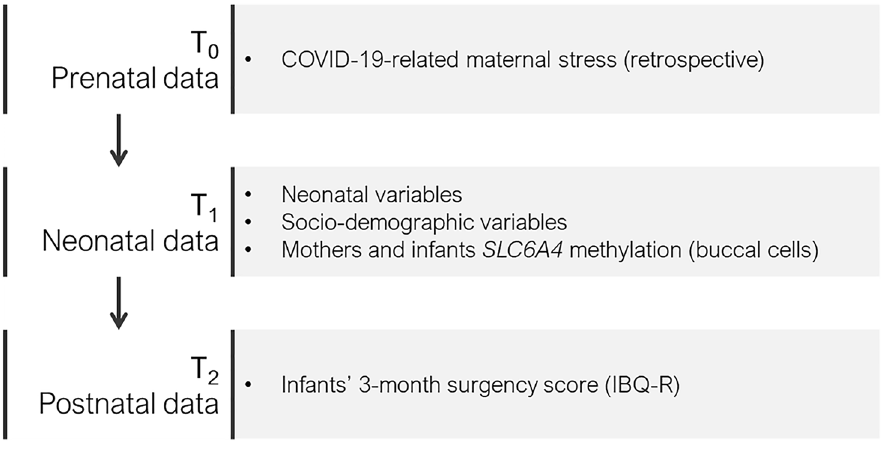
Figure 1. Overview of the